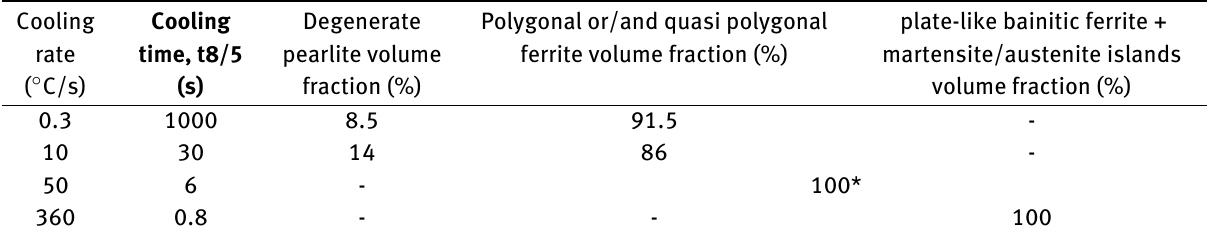
Table 3: Volume fractions of the phases in the microstructures of weld simulated API 5L X-60 pipeline steel samples at different cooling rates.